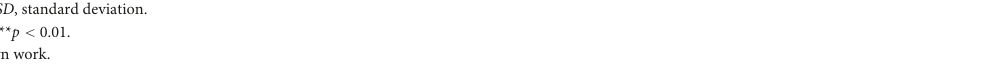
TABLE 7 Pearson’s linear correlation coefficient for maternal–fetal attachment (MFA) and maternal perceived stress with its components. Variable M ( SD